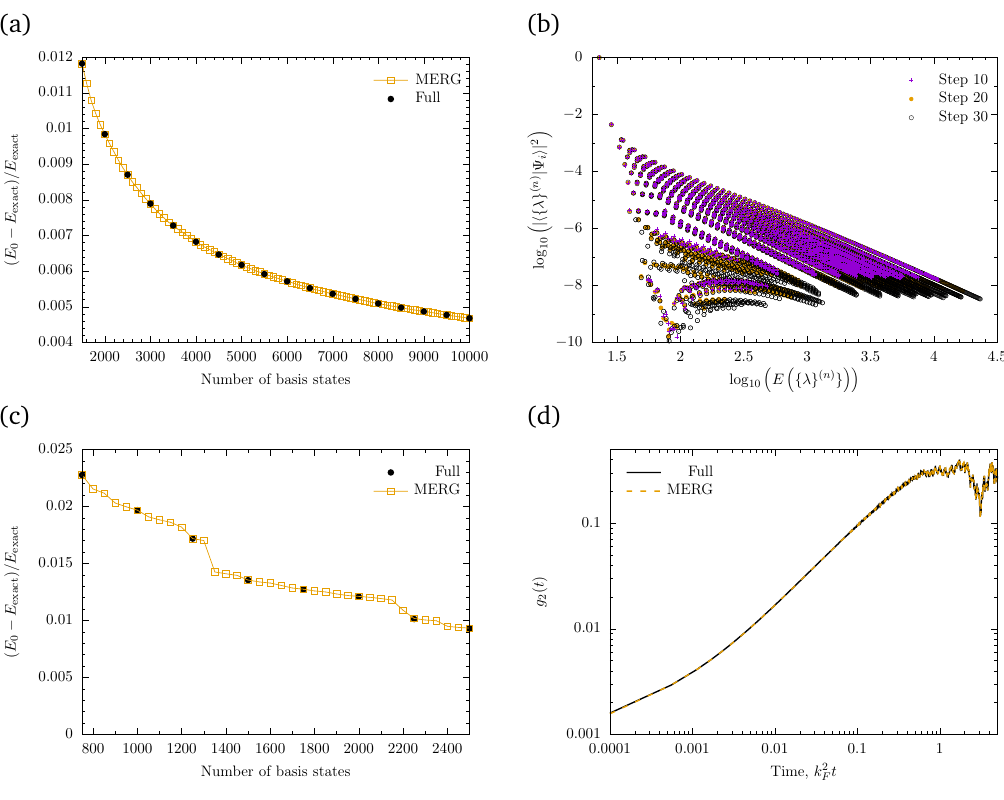
Figure 18: Top row: Matrix element renormalization group (MERG) and numeri- = 20 → c = 10 quench for N = 10 cal renormalization group (NRG) for the c i f particles, computed within the high overlap states truncation scheme. (a) The con- vergence of the initial state energy as a function of number of basis states; (b) the convergence of the overlaps at different steps of the MERG procedure (cf. Fig. 9). Bottom row: MERG and full diagonalization results for the N = 4 particle quench = 100 → c = 3.7660: (c) the convergence of the energy of the initial state with c i f ( t ) with 2500 basis the number of basis states; (d) the time evolution of g 2